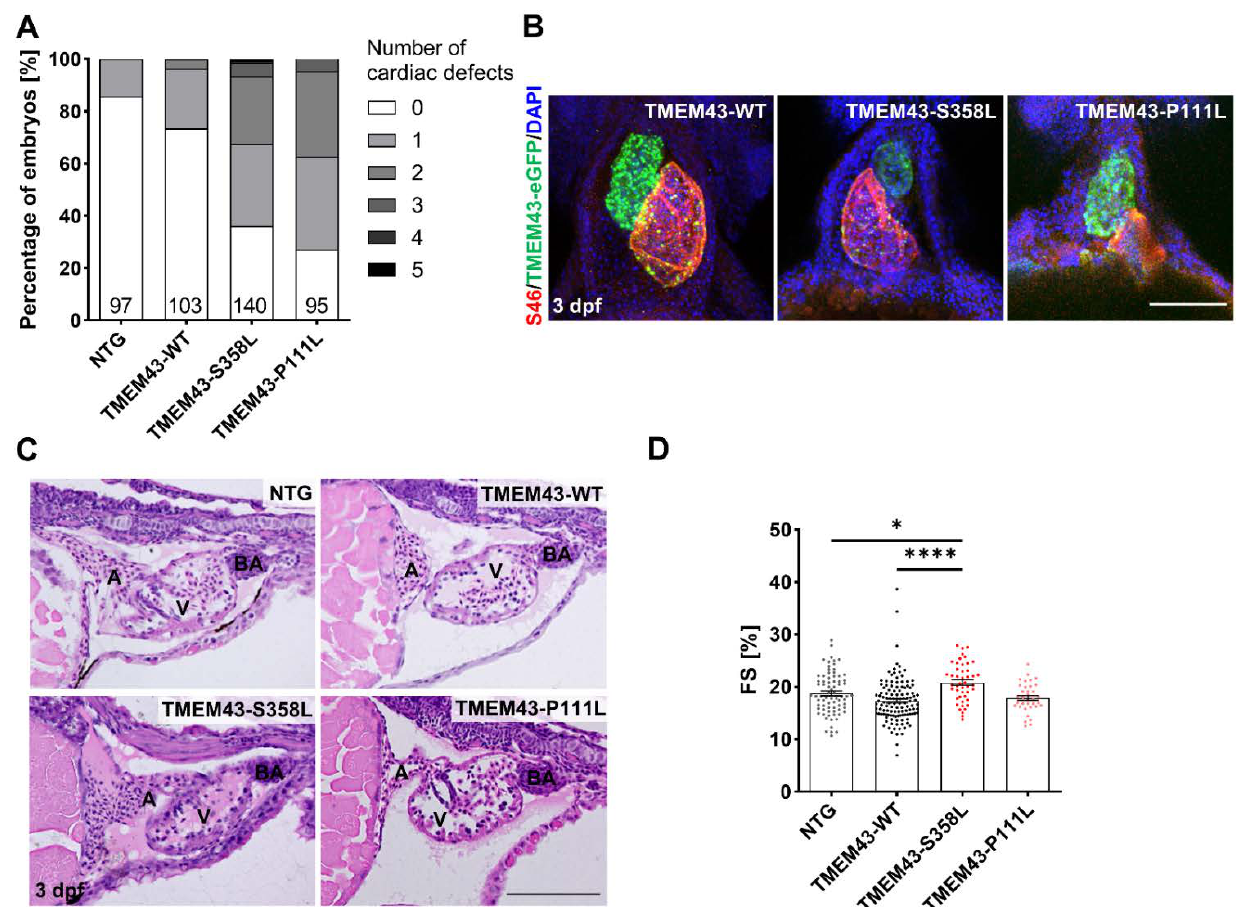
Figure 3. Overexpression of TMEM43 variants induce altered cardiac morphology and function at 3 days post-fertilization (dpf). ( A ) Visual phenotyping demonstrates the percentage of embryos with zero to five different cardiac-specific defects. The defects were classified into looping defects, pericar- dial edemas, arrhythmias, altered ventricular shape, strong ventricular contractions, heterogenous ventricular contractions, and altered atrial shape. Both TMEM43 variant lines show an increased per- centage of embryos with at least one cardiac defect. The number of phenotyped embryos is indicated at the bottom of the columns. ( B ) Confocal maximum intensity projections of immunofluorescence- stained hearts. Atria are labeled for S46 localization (red), ventricles for GFP localization (green), and nuclei with DAPI (blue). In contrast to TMEM43-WT hearts, both TMEM43 variant lines display developmental defects (looping defects and reduced ventricular chamber size in TMEM43-S358L, as well as altered atrial chamber shape in TMEM43-P111L). Ventral views, arterial pole to the top. Scale bar = 100 µ m. ( C ) Representative histological images of hematoxylin and eosin-stained sagittal plastic sections showing structurally normal heart chambers and the outflow tract in embryos at 3 dpf ( n ≥ 5 per genotype). A, atrium; BA, Bulbus arteriosus; V, ventricle. Scale bar = 100 µ m. ( D ) Analysis of cardiac function by ventricular fractional shortening (FS) quantification from a time series of the embryonic cardiac cycle. Data points represent the average measurement obtained from three diastolic/systolic phases of each fish. The short axis of the ventricle was used for quantification. Significantly increased FS was detected in TMEM43-S358L embryos. Significance was determined by one-way ANOVA with Bonferroni’s multiple comparison test, * p ≤ 0.05, **** p ≤ 0.0001. Error bars correspond to SEM. ( A , D ) Analyses were performed on embryos from three independent clutches per